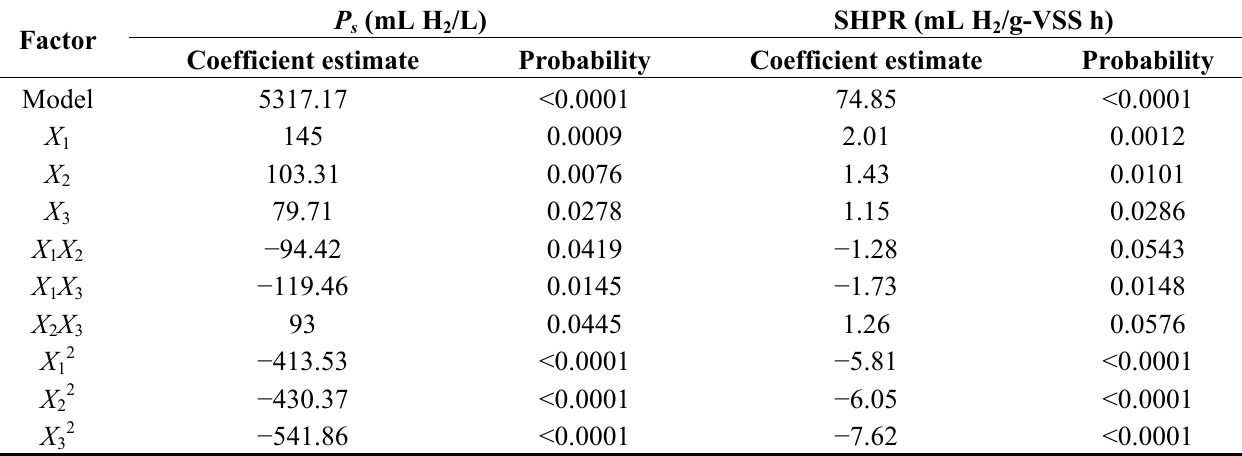
Table 4. Model coefficients estimated by multiple linear